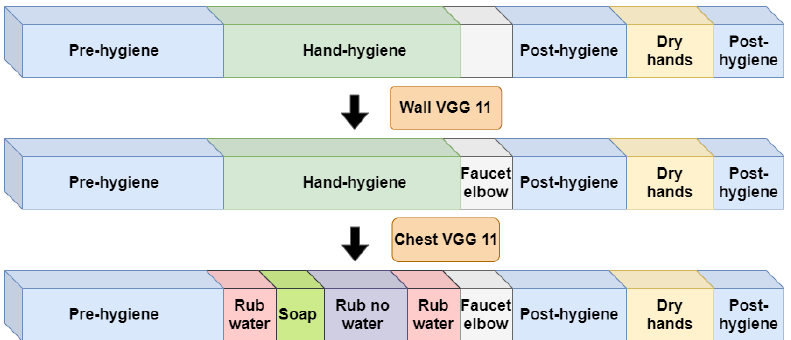
Figure 7. System stage 2: Trimmed hand-hygiene video processing with refinement classifiers.